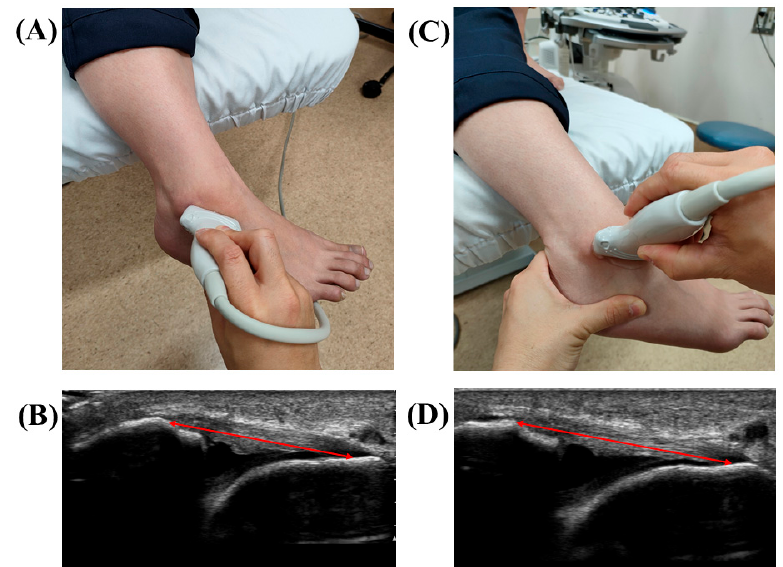
Figure 2. Ultrasonographic evaluation of the anterior talofibular ligament (ATFL). ( A ) Nonstress ATFL position. ( B ) An ultrasonographic picture of the nonstress ATFL. The red arrow shows ATFL length. ( C ) Stress ATFL position. Manual maximal internal rotation with varus talar tilt was applied to the ankle. ( D ) An ultrasonographic picture of the stress ATFL. The red arrow shows ATFL length.